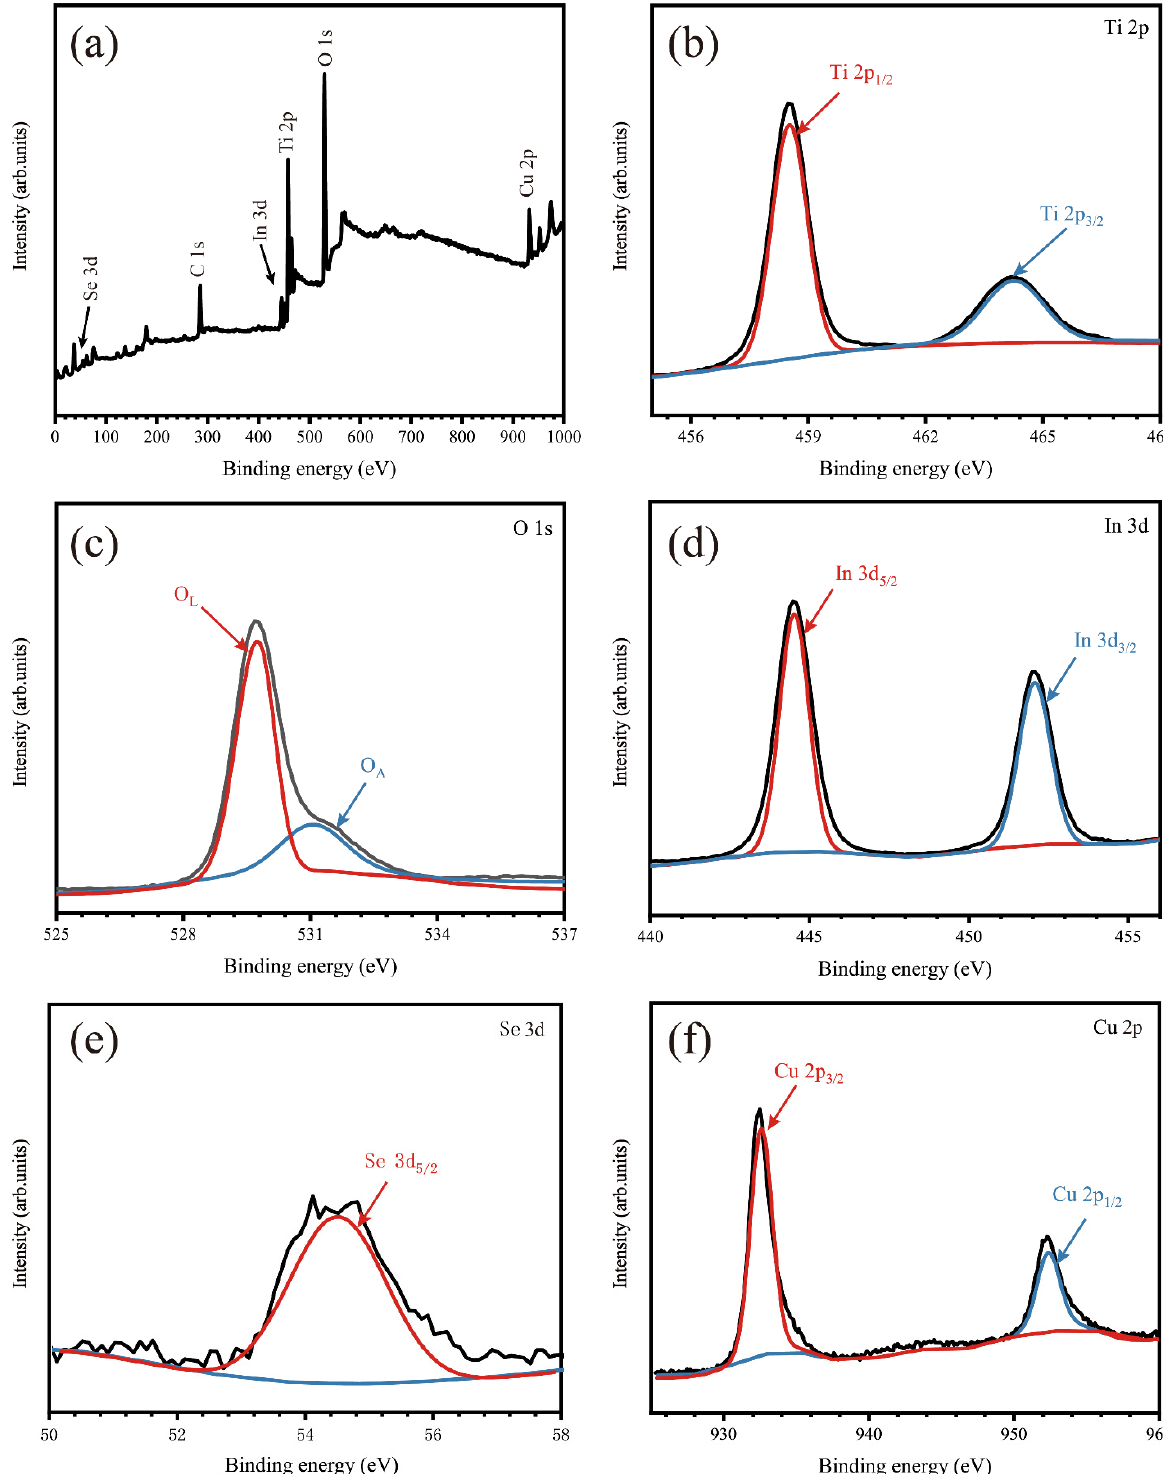
Figure 4. ( a ) The total XPS survey spectrum; high ‐ resolution spectra of ( b ) Ti 2p, ( c ) O 1s, ( d ) In 3d, ( e ) Se 3d and ( f ) Cu 2p of CuInSe 2 /TiO 2 ‐ B NTAs. ( e ) Se 3d and ( f ) Cu 2p of CuInSe 2 /TiO 2 -B